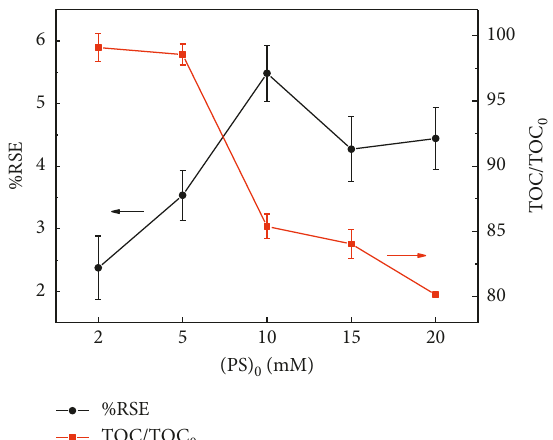
� 0.1 mM; [PS] � 2–20 mM; 0